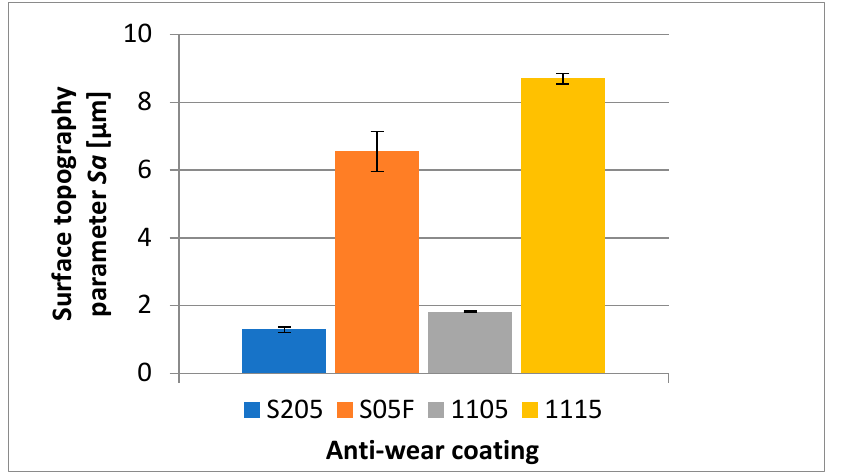
Figure 6. The influence of the cutting insert coating on the average value of the Sa topography parameter of the machined surface.